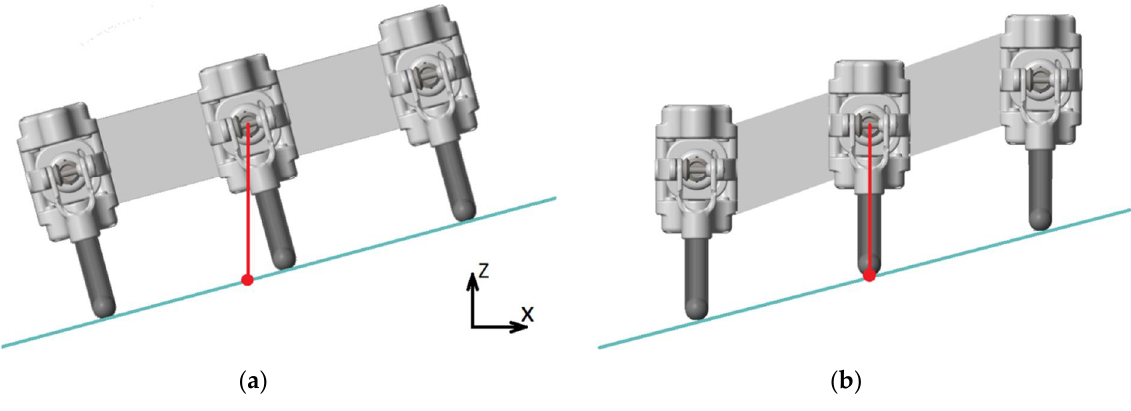
Figure 1. Robot legs with ( a ) 3 DOFs; and ( b ) 4 DOFs.